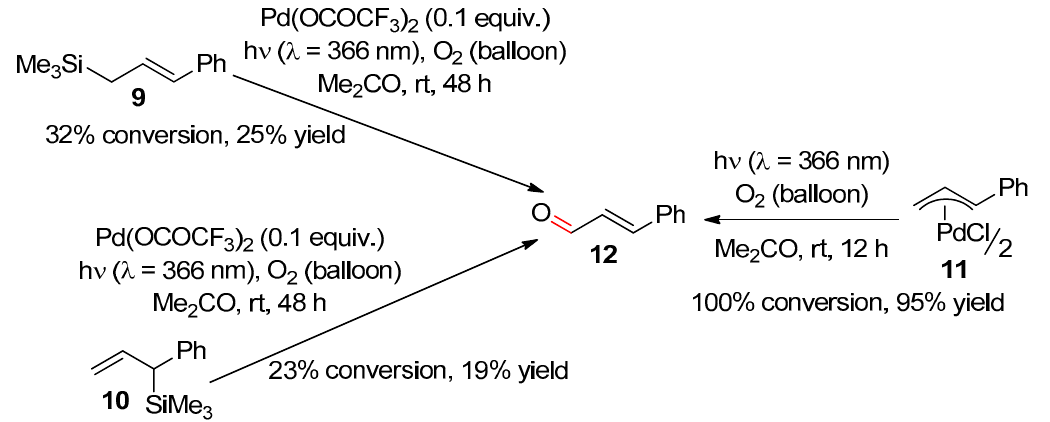
Scheme 2. Three photochemical reactions leading to cinnamaldehyde.